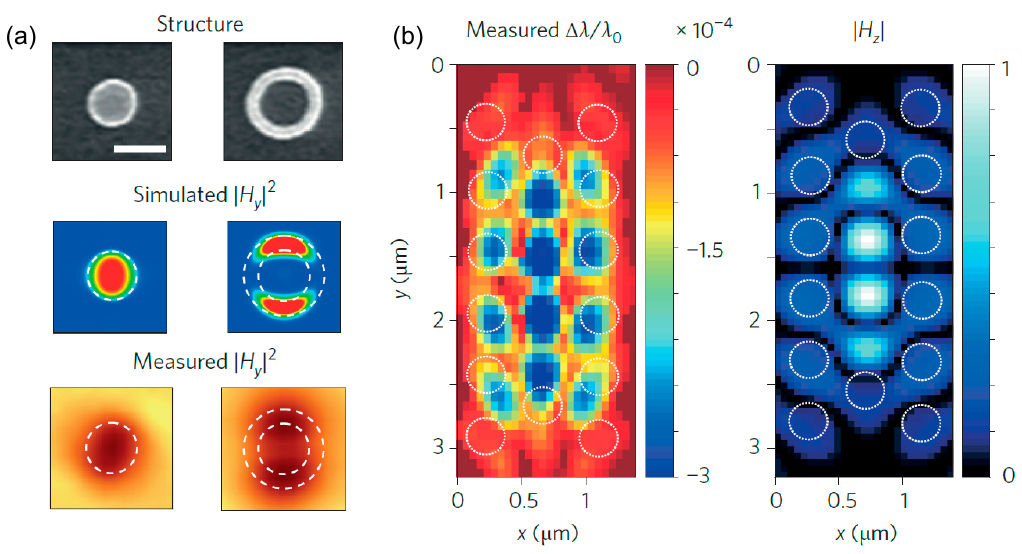
Figure 2. Electromagnetic near-fields probed with c-SNOM. ( a ) An example of magnetic near-field maps ( H y ) of single nanostructures taken with a pyramid-probe c-SNOM, scale bar is 300 nm [28]. ( b ) Measurements of the resonance shift of a photonic crystal nanocavity collected with a circular aperture c-SNOM probe (left). The distribution of the out-of-plane component Hz of the unperturbed cavity can be calculated from the resonance shift map (right). Reproduced with permission from [8], Copyright Nature Photonics, 2014.